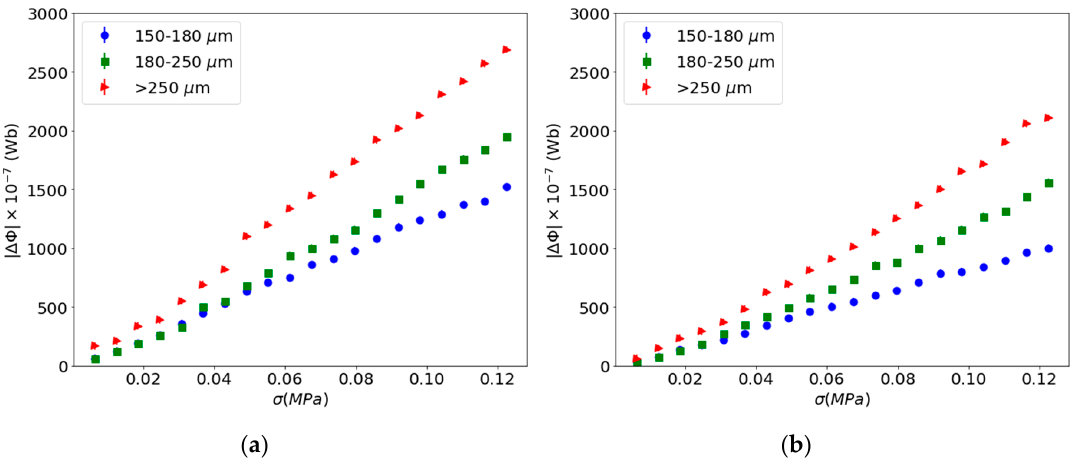
Figure 10. Strain-Villari effect of the composite submitted to a magnetic field of 1 T: ( a ) Measured with field of 2 mT (fourth step); ( b ) measured without field (fifth step).